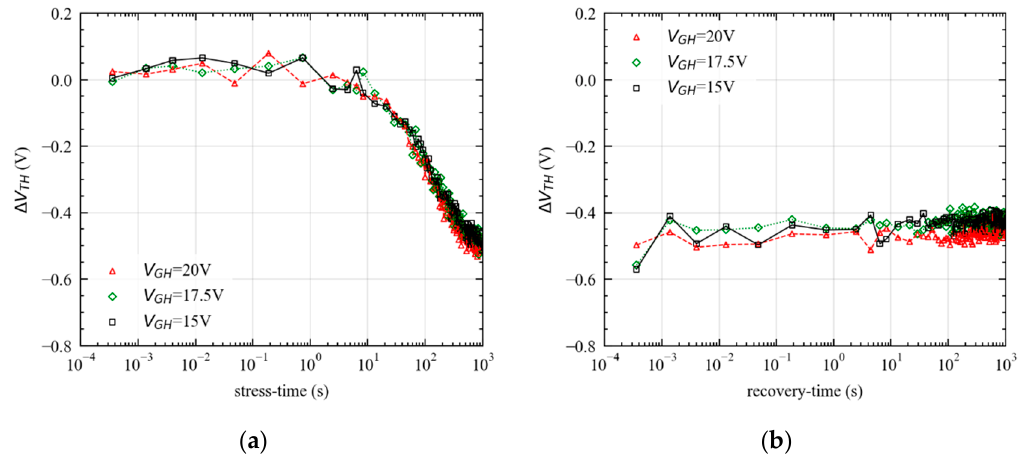
Figure 7. ( a ) Effect of gate voltage level ( V GH ) on the V TH drift during the stress with V PH = 100 V. ( b ) Monitored V TH recovery at different V GH levels (15 V, 17.5 V, and 20 V) with V PH = 100 V.